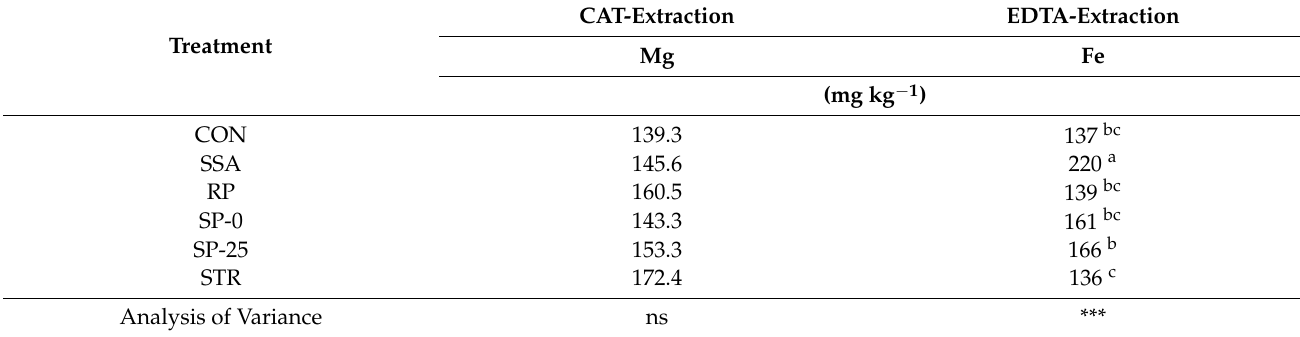
Table 4. Mean values of CAT-extractable magnesium (Mg) and EDTA-extractable Iron (Fe) (mg kg − 1 ) after fertilizer application. The same letters indicate no significant differences between the treatment (n = 4, Tukey ´ s HSD test ( α = 0.05)). Analysis of Variance: *** = p ≤ 0.001, ns = not significant ( p > 0.05). For fertilizer abbreviations see Table